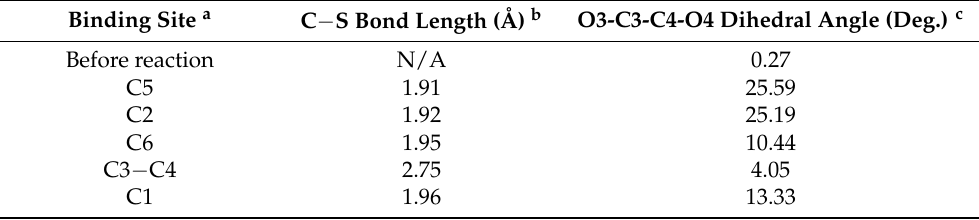
Table 1. C − S bond lengths and quinonic dihedral angles of Cys–S − -attacked intermediates.